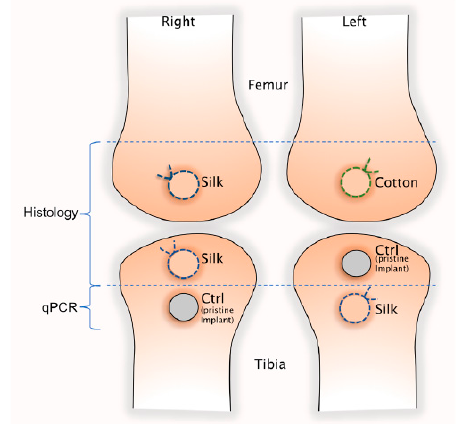
Figure 1. Schematic drawing of implant and ligature placement.